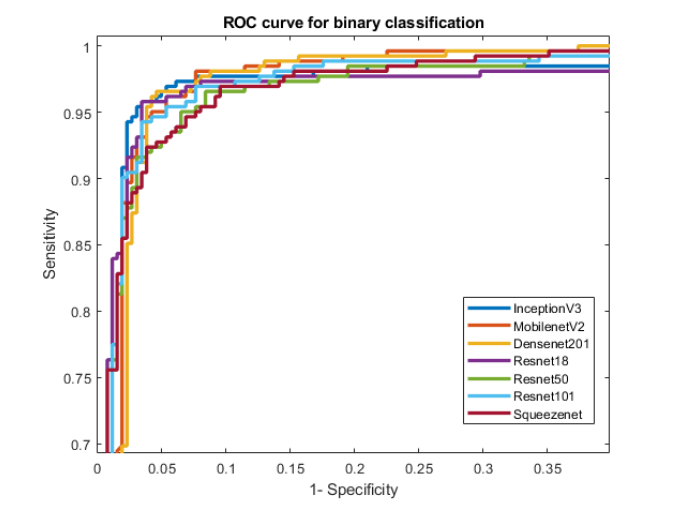
Figure 8. Comparison of the ROC curves for normal and thalassaemia classification using CNN models.